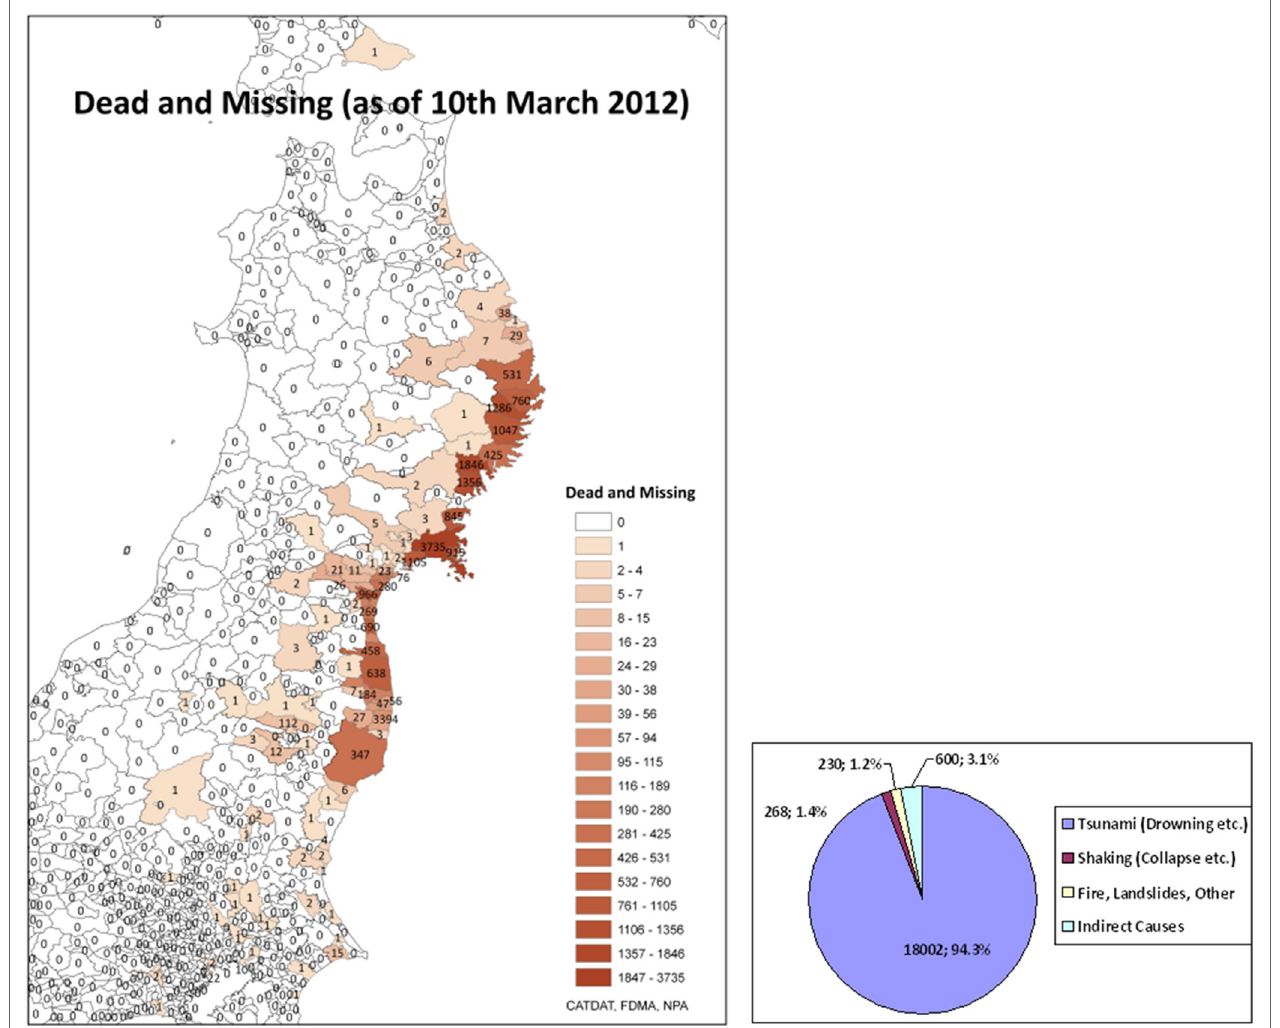
FigUre 9 | left: deaths in municipalities as collected from FDMa, national Police agency Japan (nPa) (2011), and additional Japanese sources; right: the disaggregated deaths as of 11 March 2016 (5 years after) . Of the 230 shaking deaths, only around 110 have been confirmed.